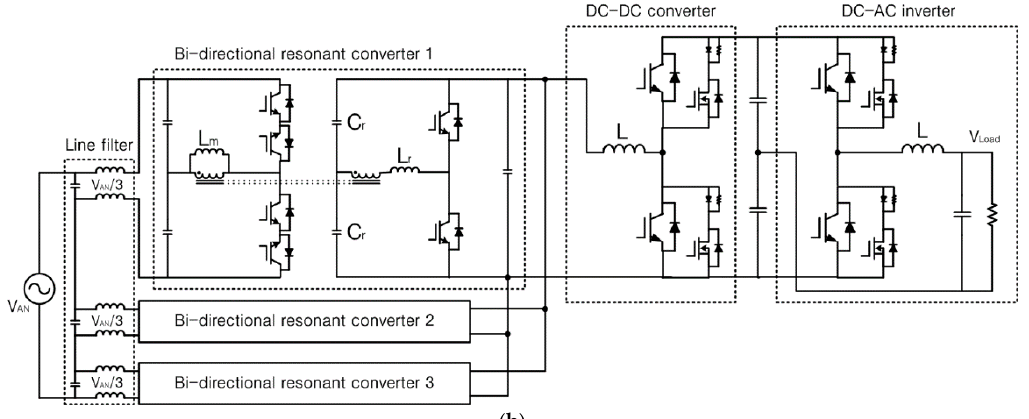
Figure 1. Configuration of bidirectional intelligent semiconductor transformer: ( a ) conceptual diagram; ( b ) circuit diagram.